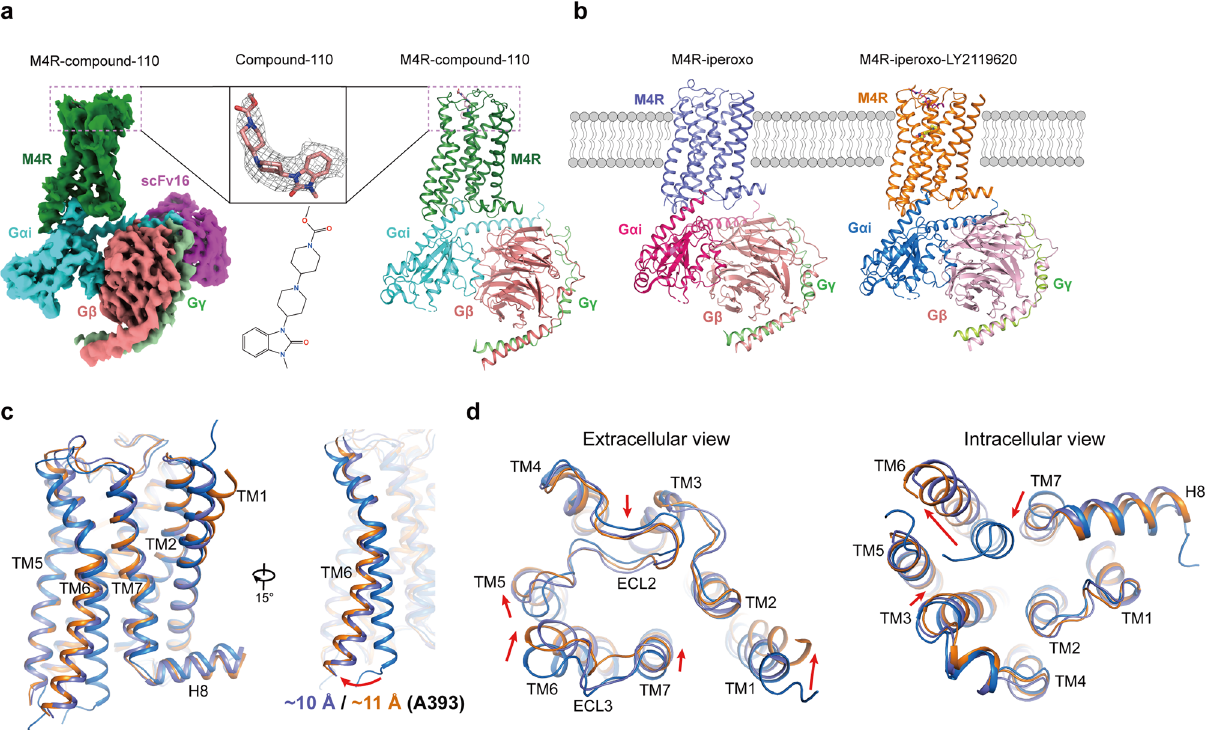
Fig. 1 Cryo-EM structures of the M4R complexes. a Cryo-EM map of M4R – G i – scFv16 in complex with compound-110 (left) and cartoon representation of the M4R – c110 – G i complex structure (right). The cryo-EM density of compound-110 (salmon) and the two-dimensional representation of the compound-110 chemical structure is shown. b The cryo-EM structures of M4R – ip – G i complex (left) and M4R – ip – LY – G i (right) complex are shown in cartoon representation. Iperoxo and LY2119620 are shown as yellow ball-sticks and magenta sticks, respectively. c The outward movement of TM6 in M4R – ip – G i and M4R – ip – LY – G i structures compared with that in inactive M4R structure (PDB code 5DSG), with residue A393 as reference. d Extracellular and intracellular views of inactive and active M4R structures. Conformational changes from inactive to active state are indicated with red